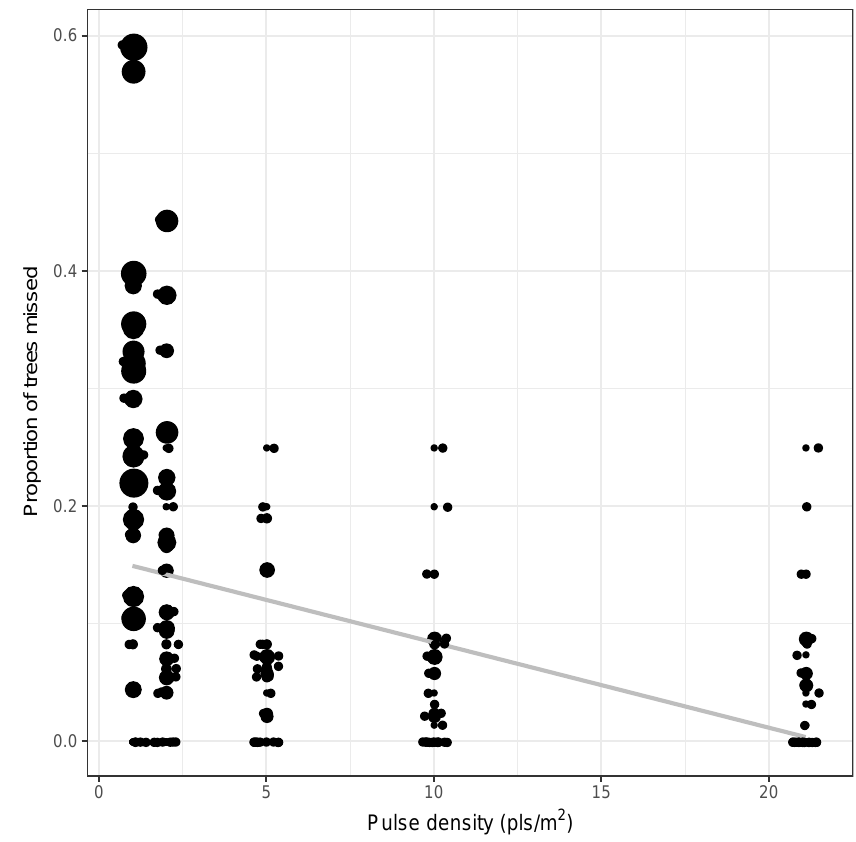
Figure 7. Proportion of invasive conifers missed per plot at each pulse density. Points are jittered to avoid over-plotting, and the point size is proportional to the mean canopy area of the missed invasive conifers in the plot. The grey line shows a linear